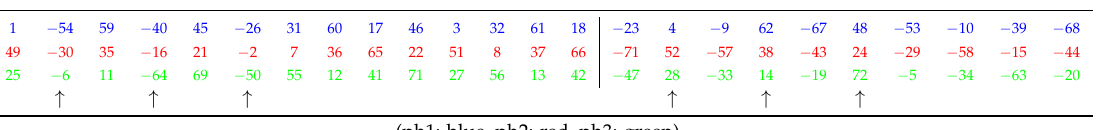
Table 19. Triple chording with a 3-rd order double-sided imbrication and zone widening by 2 coils for N = 72, p = 5, m = 3 and q = 2 + 2 / 5 .